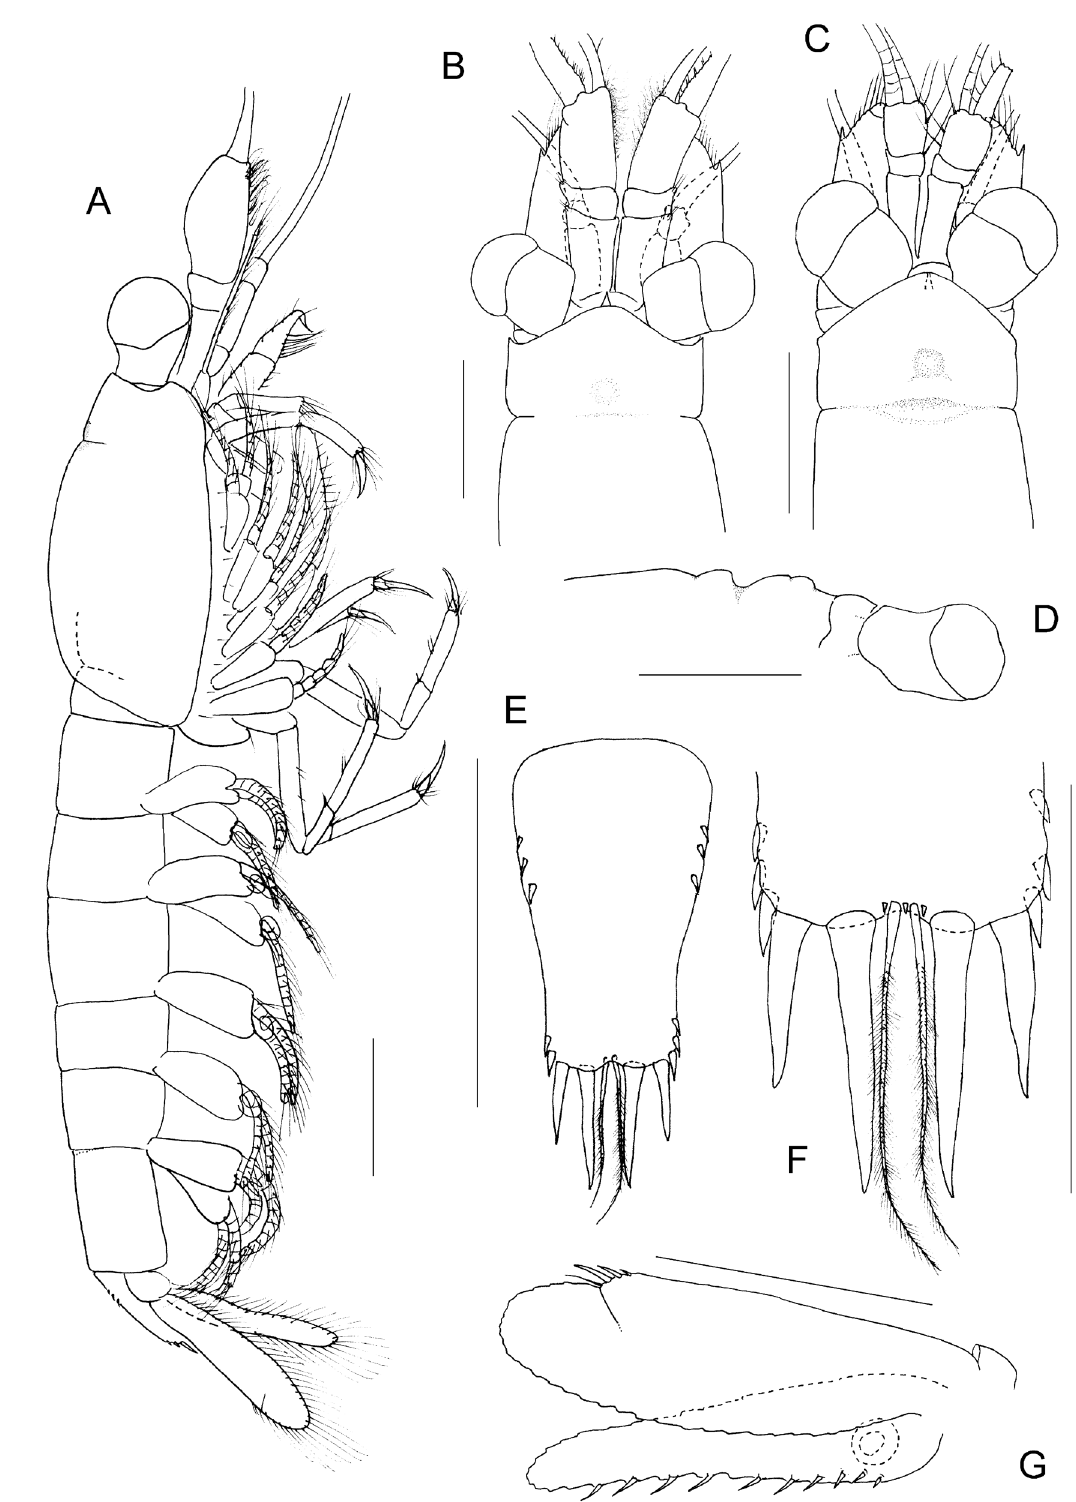
Fig. 7. Siriella brevicaudata Paulson, 1875, Arabian Gulf, Bahrain. A . Habitus. B . ♂, anterior part of body. C . ♀, anterior part of body. D . Anterior part of carapace, lateral view. E . Telson. F . Posterior part of telson, ventral view. G . Uropod, ventral view. A–B, E–G = ♂, length 4.5 mm; C–D = ♀, length 4 mm. Scale bars: A–E, G = 0.5 mm; F = 0.25